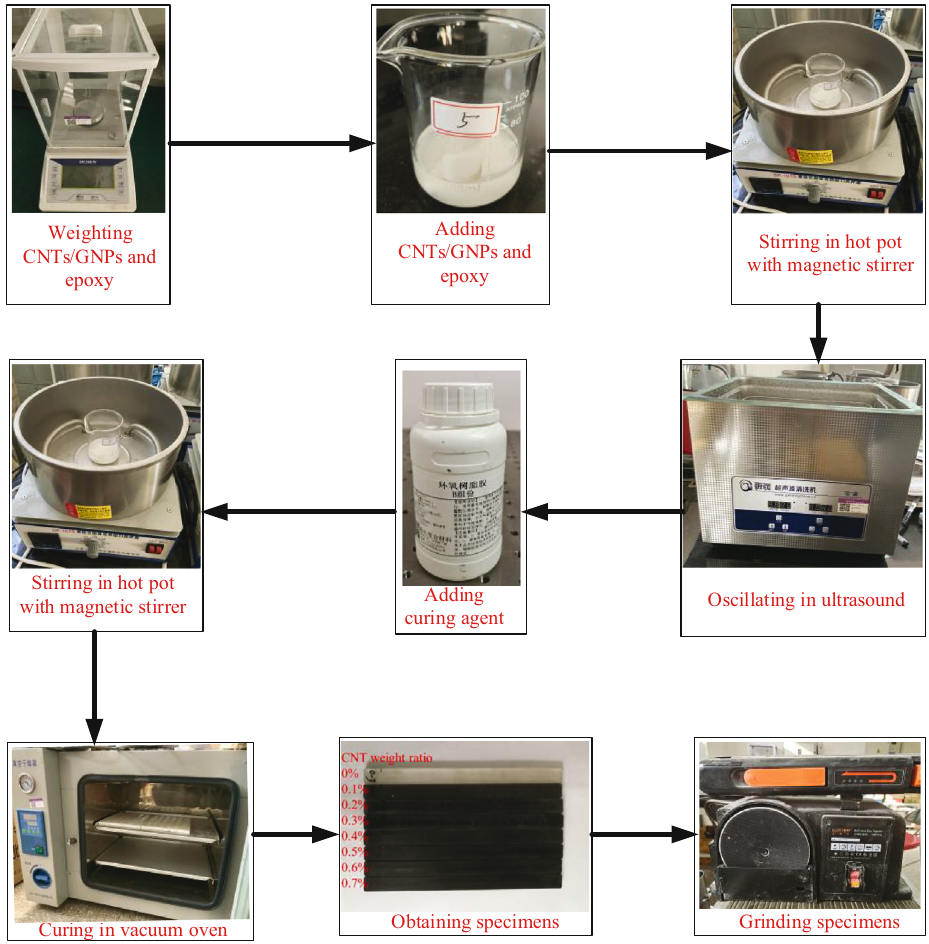
Figure 1: Preparation of epoxy nanocomposites reinforced by